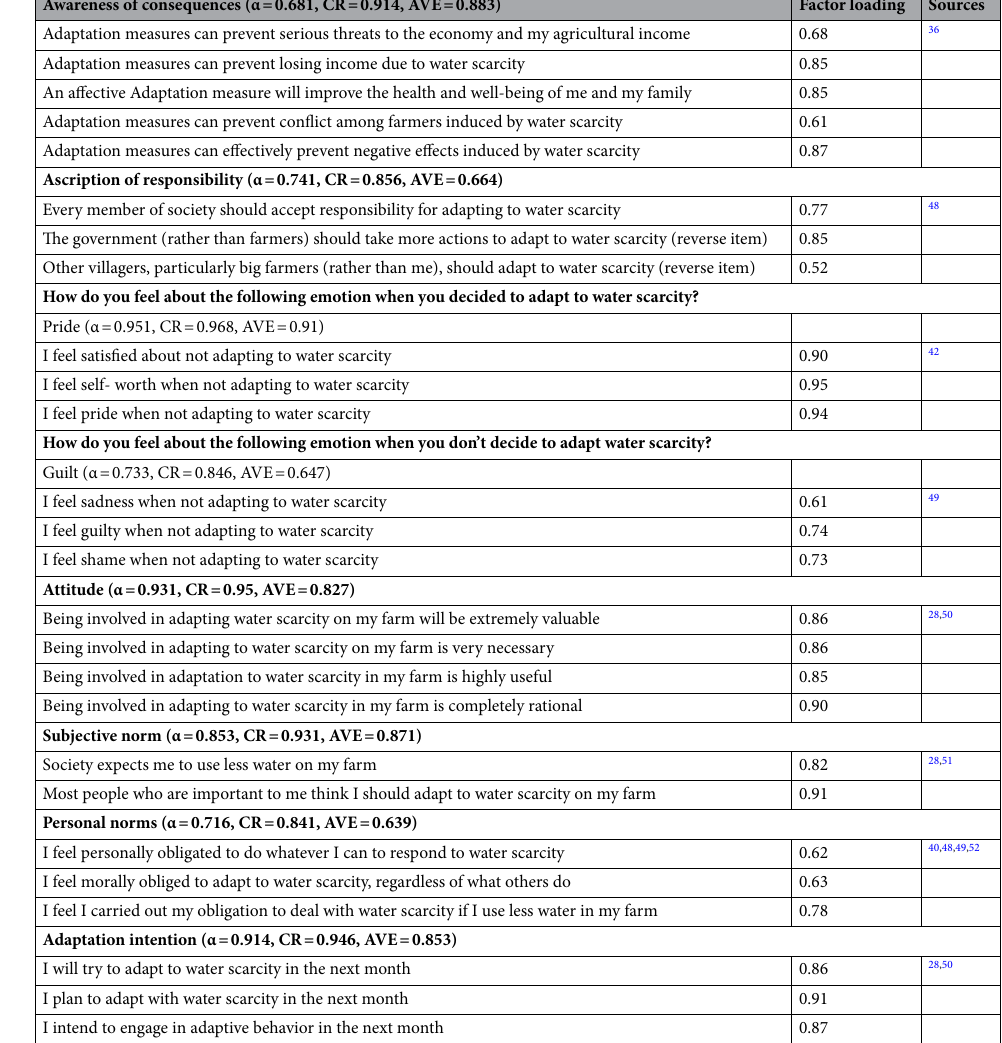
Table 1. Scales, reliability and validity indices of latent constructs and sources. Response scale (1–5); Strongly disagree–Strongly agree. α = Cronbach’s Alpha, CR = Composite Reliability, AVE = Average Variance